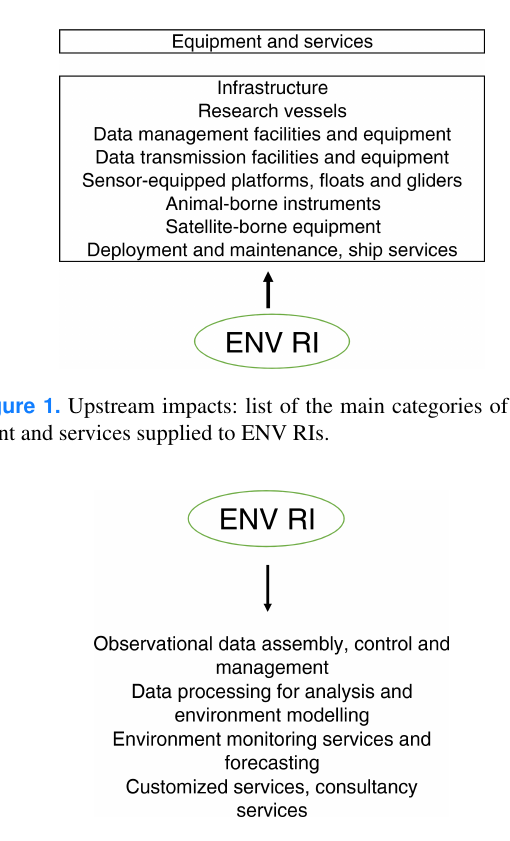
Figure 2. Downstream impacts: the different stages of data and ser- vice supply from observational and processed data to the different environment monitoring